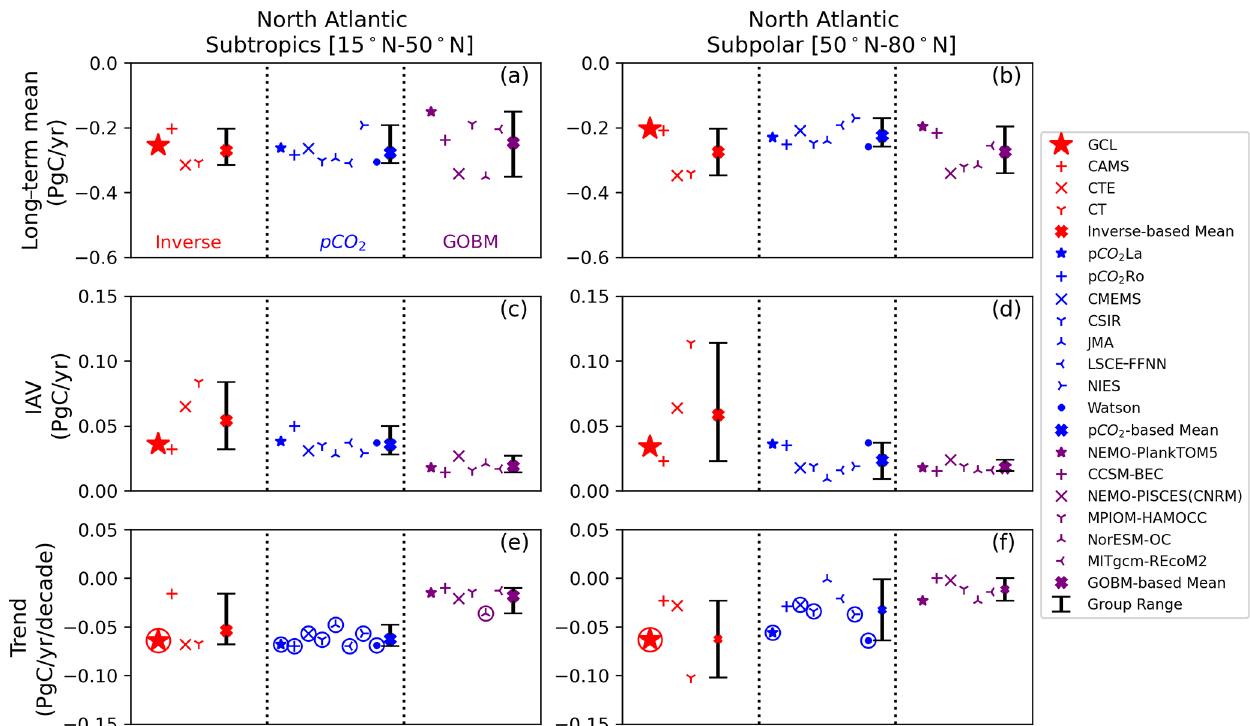
Figure 3. Comparison of CO 2 ocean flux metrics for the 2000–2017 period for North Atlantic subtropics (a, c, e) and subpolar re- gions (b, d, f) . Metrics shown are the long-term mean (a, b) , interannual variability (IAV) (c, d) , and long-term trend (e, f) . The GCL estimates (red stars) are shown in comparison to other atmospheric inverse analyses (red symbols), surface ocean p CO 2 products (blue), and global ocean biogeochemistry models (GOBMs, purple). Also shown are the estimated mean values from each subgroup of analyses (filled cross symbols) with their minimum to maximum range. Circled symbols in (e) and (f) indicate a statistically significant